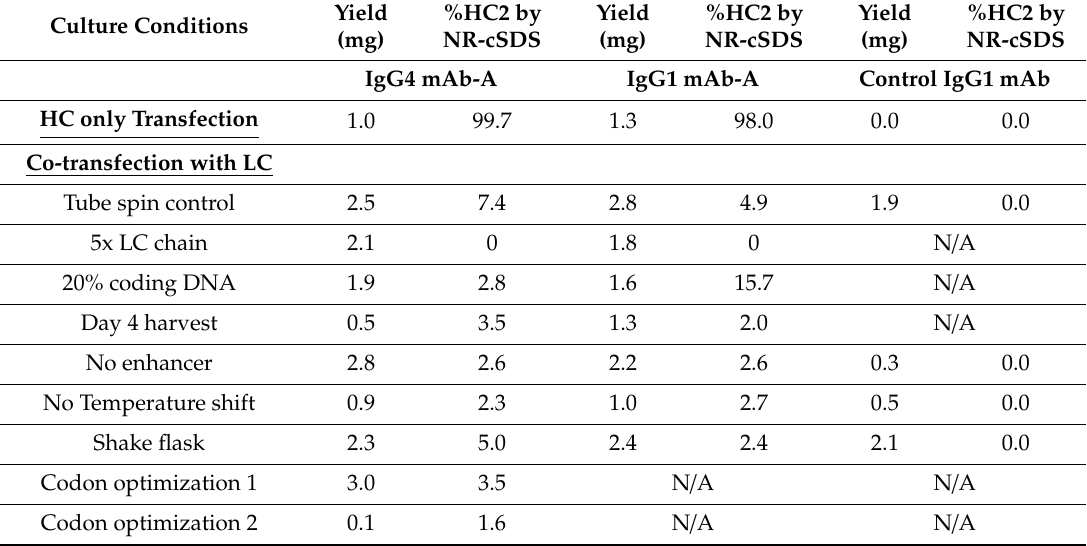
Table 1. Expression variables, codon usage, and isotype evaluated for their e ff ects on mAb-A HC2 formation for 10 mL small-scale transient cultured CHO cells. Yield in milligrams refers to the amount of mAb expressed and a ffi nity captured by ProA except for the HC-only transfection, where yield is the amount of HC2 expressed and purified. Control IgG1 mAb did not yield measurable amounts of HC2 with both HC-only transfection and HC / LC